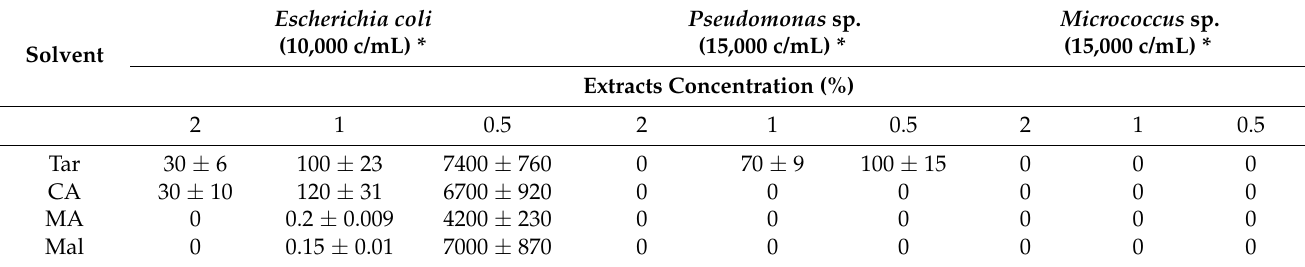
Table 3. The number of bacterial cells in solution (c/mL) when extracts are used.